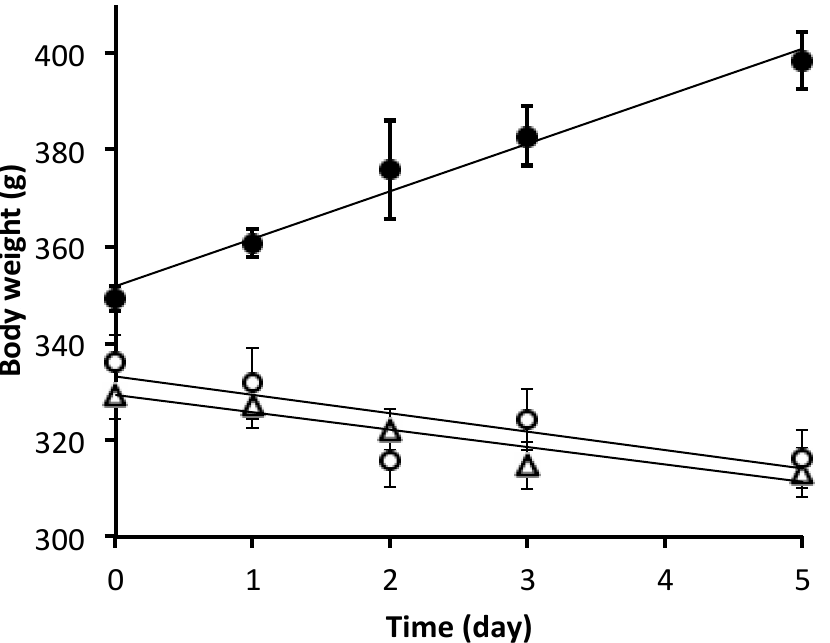
Figure 1. Body weight over the duration of the experiment. Data are presented as mean ± S.E.M. ( n = 6–8/group/day). The equations of the linear curves were obtained by taking into account all the animals of the concerned group. Dark circle: reference group; y = 9.7 g day − 1 + 352 g, r 2 = 0.64, p < 0.01. Open triangle: parenteral nutrition (PN) group; y = − 3.6 g day − 1 + 329 g, r 2 = 0.18, p < 0.01. Open circle: PN + 10 µM disulfide glutathione (GSSG) group; y = − 3.8 g day − 1 + 334 g, r 2 = 0.18, p = 0.02.